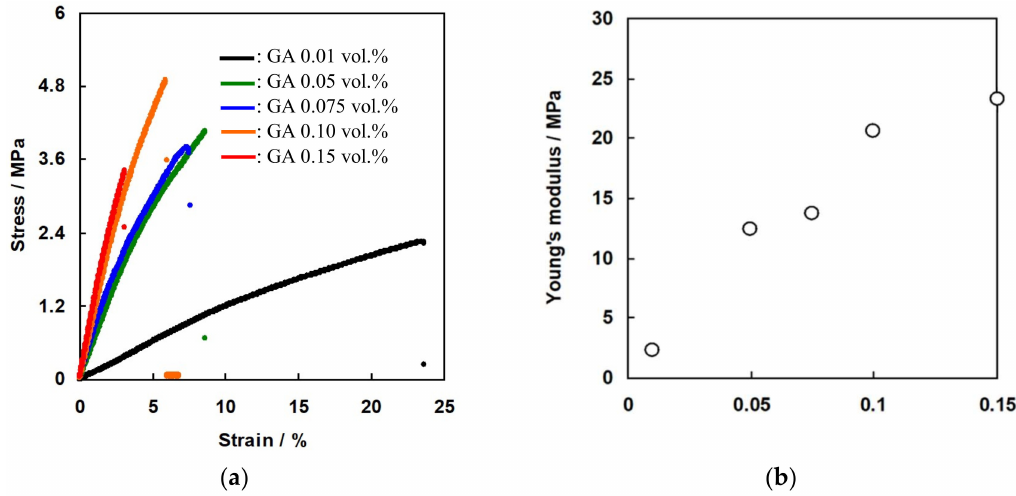
Figure 12. ( a ) Stress-strain curve of A-HF membranes. ( b ) Young’s modulus of A-HF membranes as a function of GA